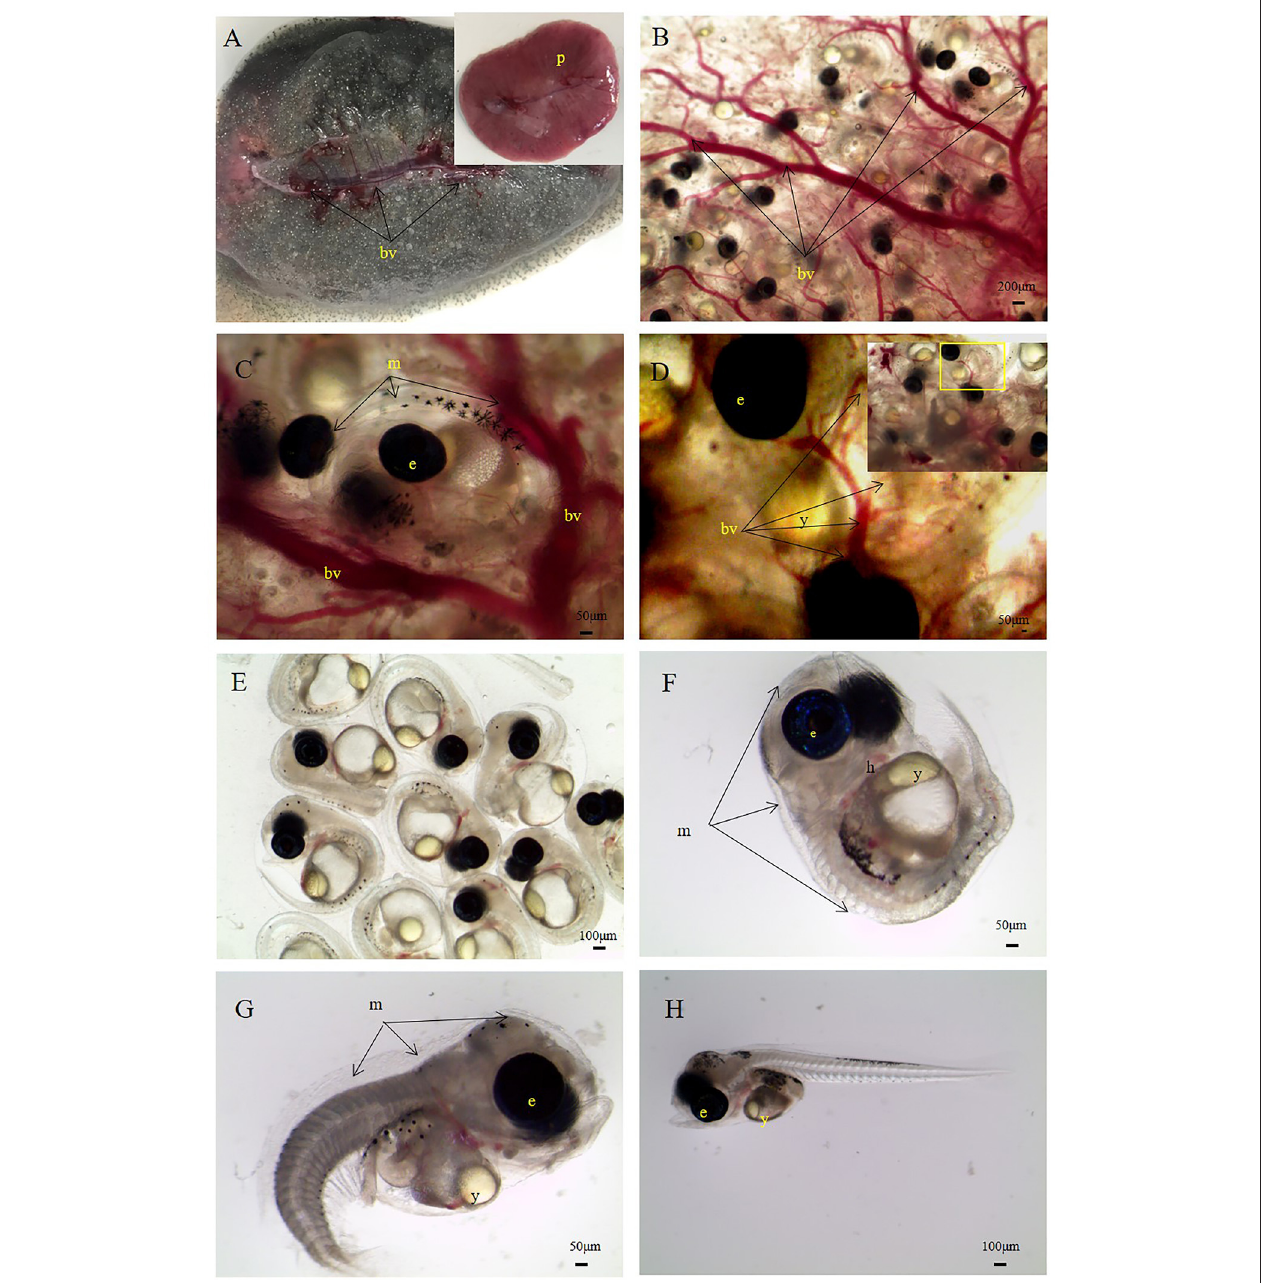
FIGURE 2 | S. schlegelii embryos during the organogenesis stage. (A) Ovary with a large central blood vessel (bv) and a placentome (p). (B) Embryos are surrounded by blood vessels. (C) An embryo wrapped in an egg membrane (m) with many blood vessels around. (D) Blood vessels around the egg membrane, (E) embryos, (F) an embryo enveloped by an egg membrane. (G) A newly broken and curled embryo. (H) A broken and unfolded embryo. e, eye of the embryo; h, heart of the embryo; y, yolk of embryo. Scale bars, 200 µ m (B) ; 50 µ m (C,D,F,G , ; 100 µ m (E , H) .